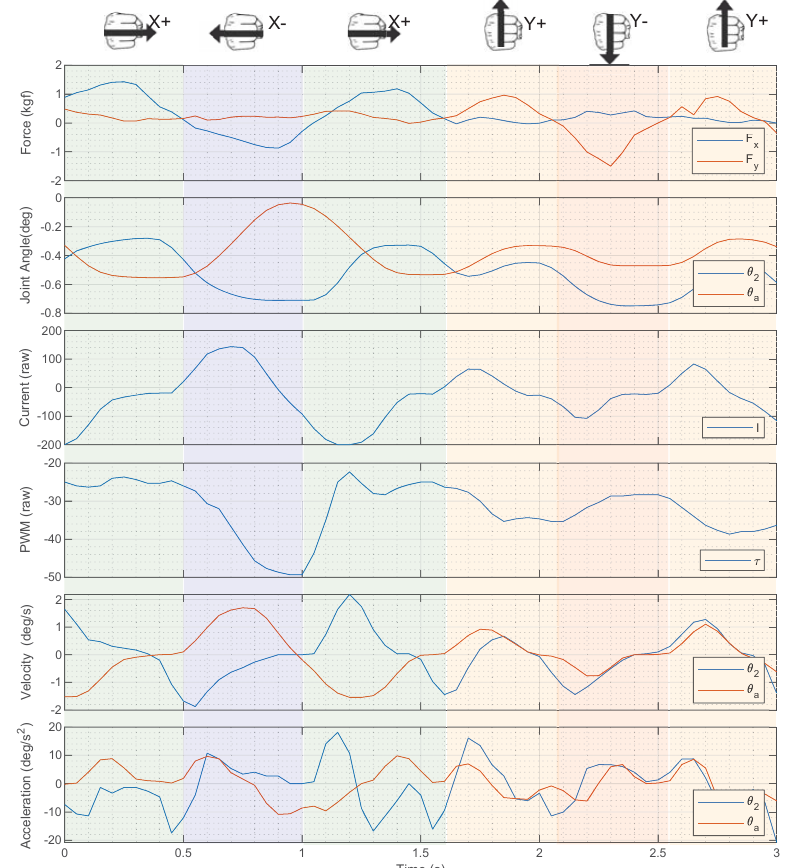
Figure 6. Excerpt from the data collected during experiments: exerted forces ( F x , F y ) and the input parameters position ( θ 2 , θ a ), current ( I ), PWM ( P ), velocity ( ˙ θ 2 , ˙ θ a ), and acceleration (¨ θ 2 , ¨ θ a ), for left finger. Right finger data are